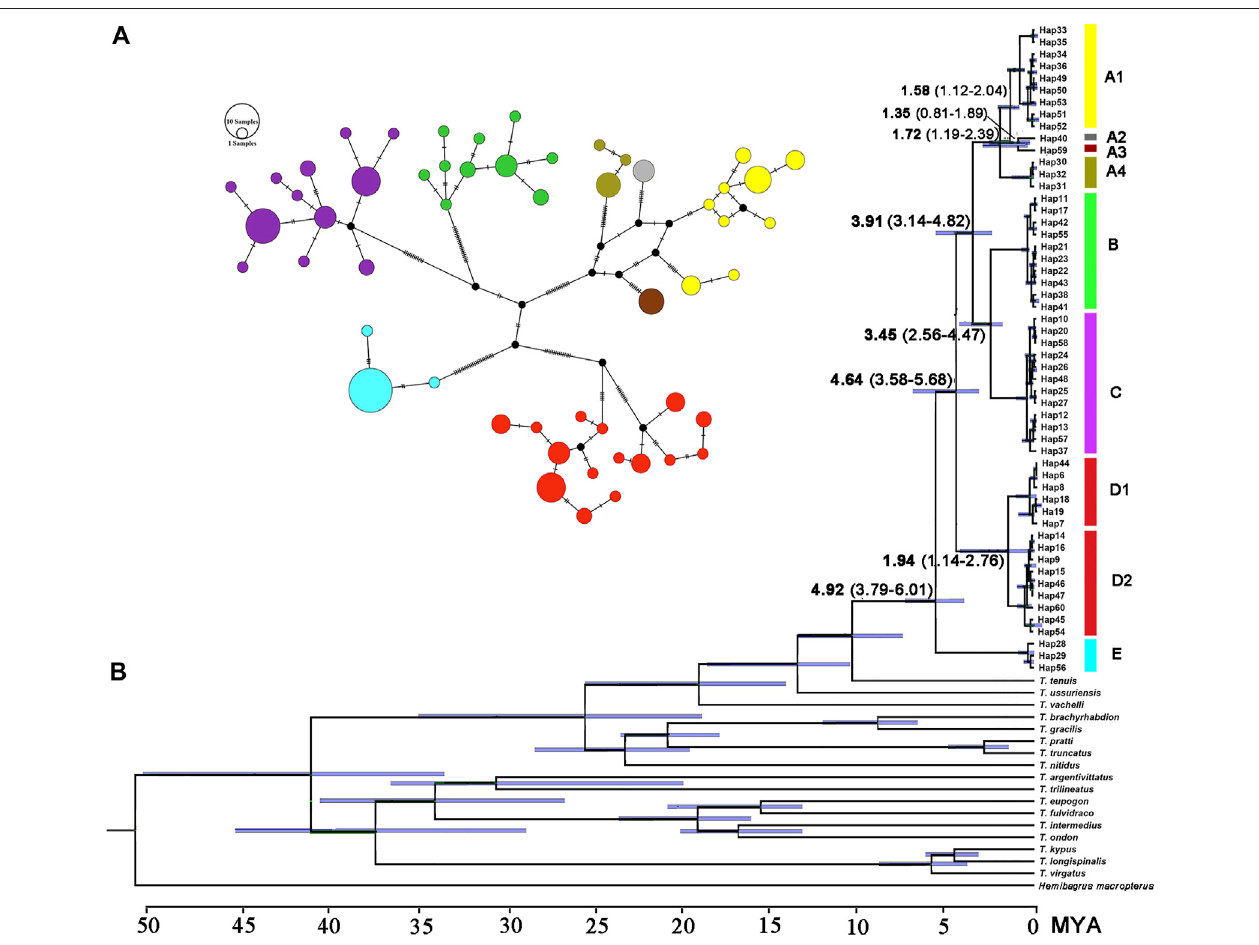
FIGURE3|(A) Median-joiningnetwork(eachcirclerepresentsahaplotypeproportionaltoitsfrequencycoloredbythegeneticsplitinthephylogenetictree)and (B) the chronogram (BEAST) of the main divergence events in T. albomarginatus s.l. inferred for the concatenated Cyt. b and COI